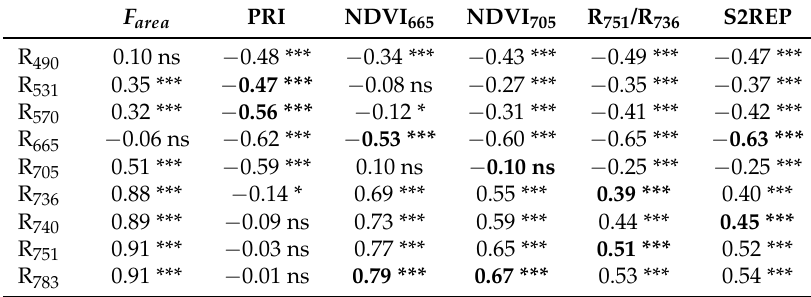
Table 1. Spearman’s rank-order correlation coefficients between single band reflectance factors in blue (490 nm), green (531 nm and 570 nm), red (665 nm), red-edge (705 nm) and near infrared (736 nm, 740 nm, 751 nm and 783 nm) spectral regions and spectral transformations: in-filling of the O 2 -A Fraunhofer line around 760 nm ( F area ), Photochemical Reflectance Index (PRI), red NDVI (NDVI 665 ), red-edge NDVI (NDVI 705 ), new simple ratio at 736 nm and 751 nm (R 751 /R 736 ), and red-edge inflection point estimated by linear four-point interpolation approach (S2REP). Asterisks denote statistical